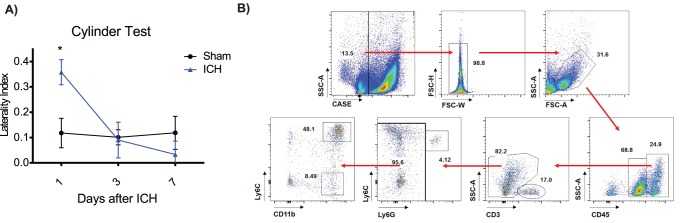
Ly6Clo monocytes are present in the ipsilateral hemisphere 72 hours after ICH.
A) WT mice were cylinder tested 1, 3, and 7 days after either sham or ICH surgery. Means graphed with s.e.m., n = 6–8, *p<0.05 B) Ly6Clo monocytes are found in the ipsilateral hemisphere 3 days after ICH when mice recover by cylinder test. Cells were gated on live/dead, singlets, leukocytes were found by forward and side scatter, and then further gated to isolate populations as shown in these representative plots.